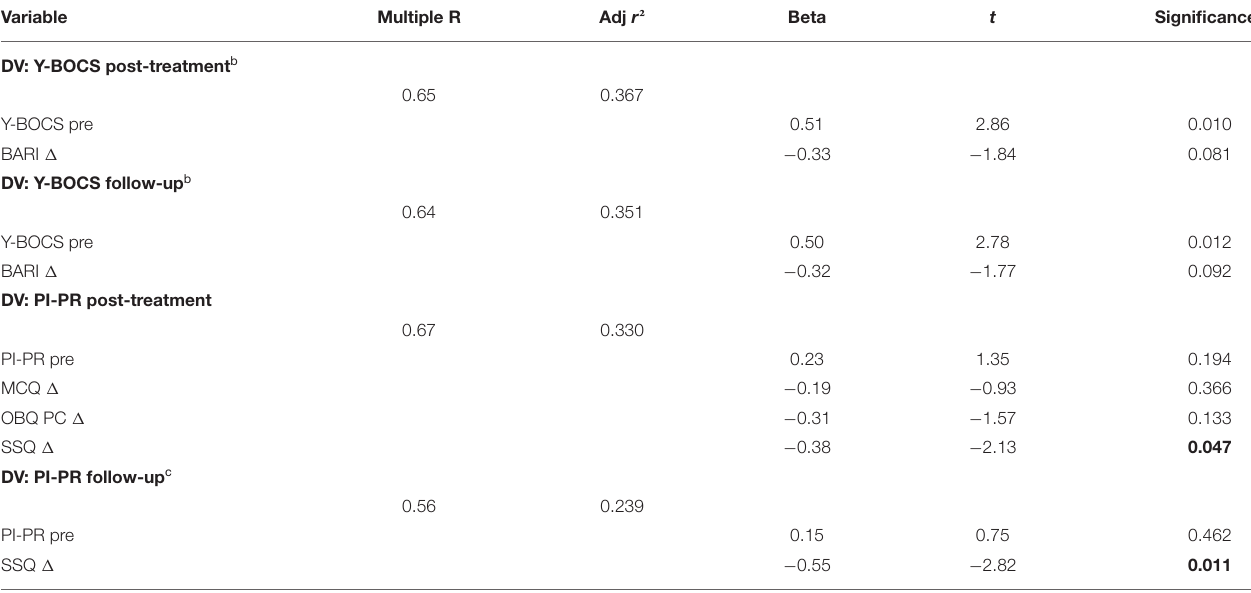
TABLE 4 | Summary statistics for the final model of the equation in the regression of obsessive-compulsive symptoms at post-treatment and follow-up.